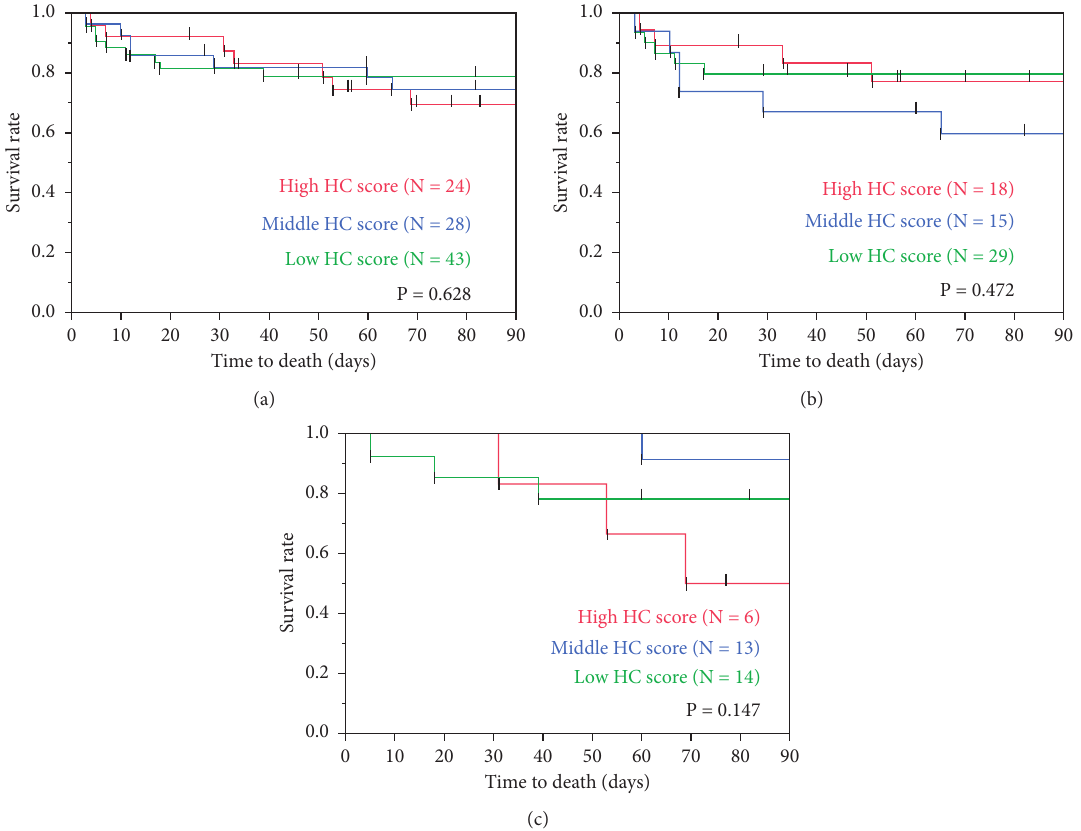
Figure 3: Comparison of patients with high, middle, and low honeycomb scores. In patients with AEs of idiopathic ILDs and secondary ILDs and overall patients, there is no significant difference in 3-month mortality among the groups with low (0 point), middle (1–4 points), and high ( ≥ 5 points) honeycomb scores. AE, acute exacerbation; ILD, interstitial lung disease. (a) Overall. (b) Idiopathic. (c) Secondary.